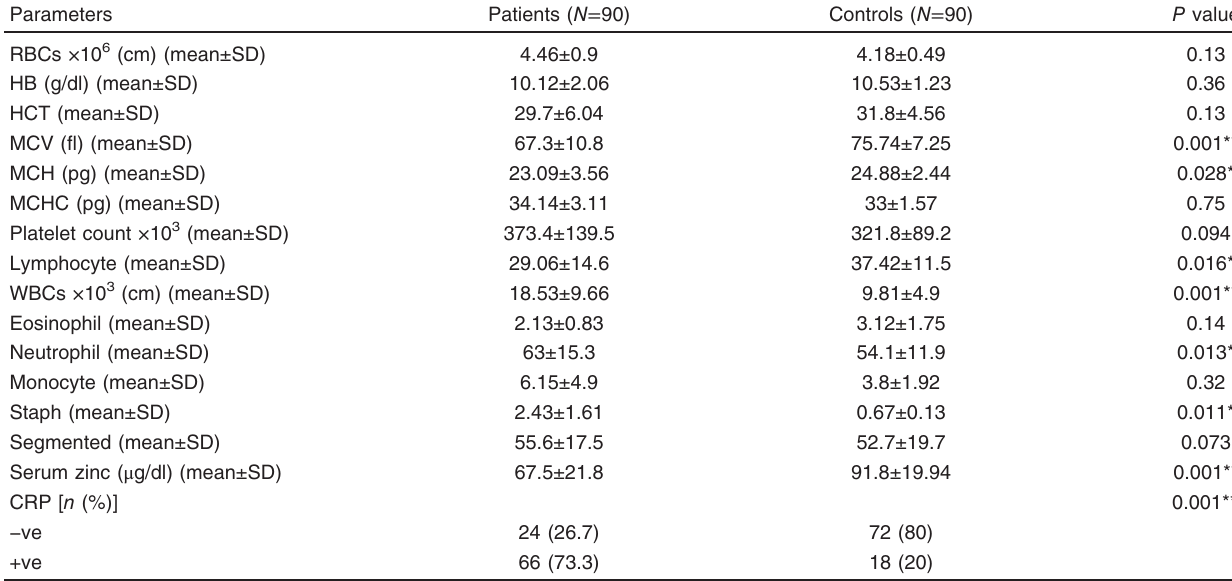
Table 3 Comparison between patients and controls regarding complete blood count, serum zinc level, and C-reactive protein ( N = 180)